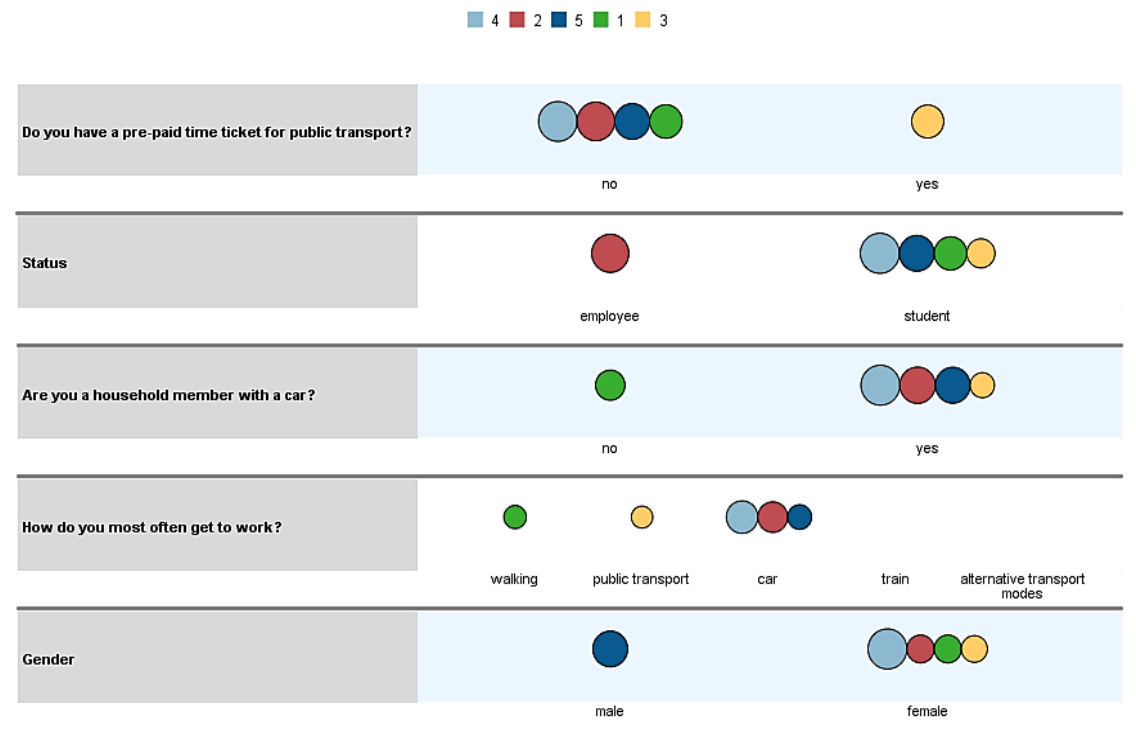
Figure 4. Cluster Figure 4. Cluster comparison.